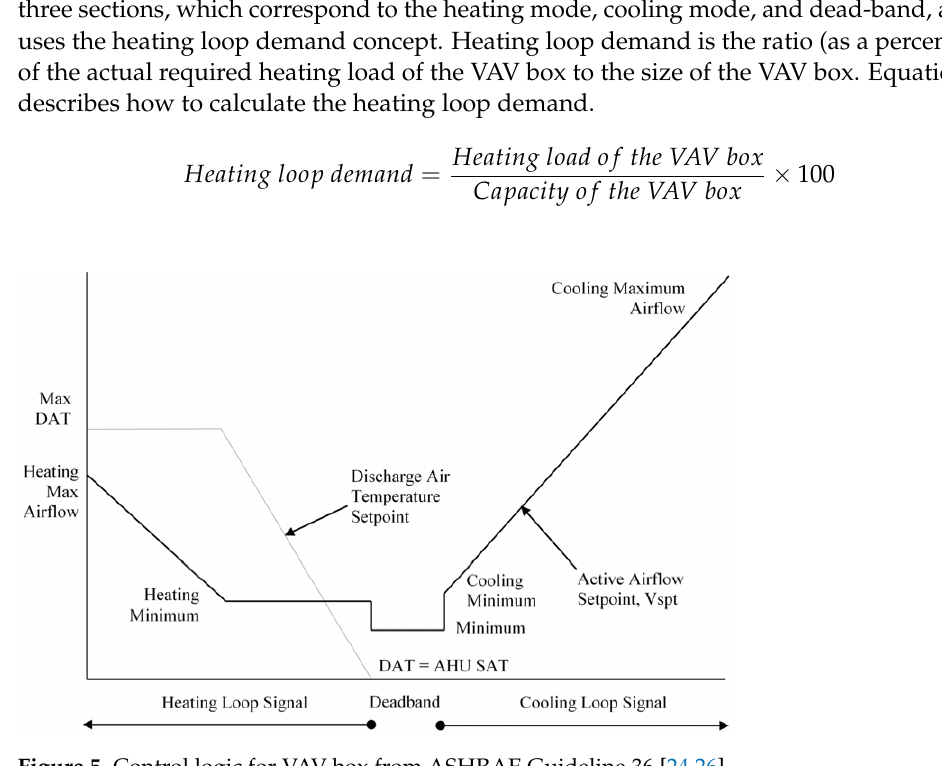
Figure 5. Control logic for VAV box from ASHRAE Guideline 36 [24,26].